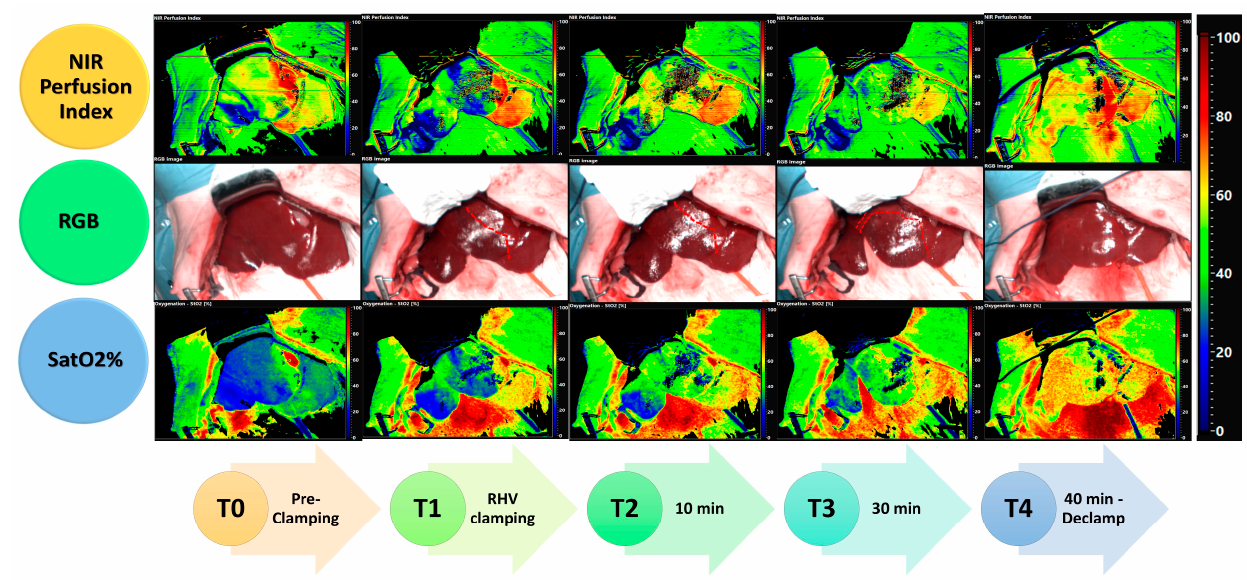
Figure 2. Examples of the photos acquired with the hyperspectral camera at different time points. In the first line, the near-infrared perfusion index window was controlled; in the second, the real appearance of the pig liver at different time points; in the third line, the window to check the oxygen saturation is evident.